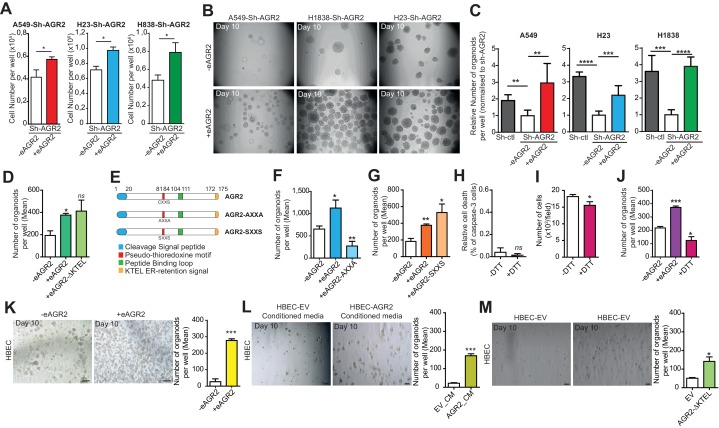
Extracellular AGR2 boosts the organoid-initiating frequency.(A) Quantification of the numbers of cells per wells following the addition of AGR2 in the extracellular medium (+eAGR2). Data are represented as mean ± SEM of at least 3 independent experiments. *p<0.05. (B) Representative brightfield images of tumor organoids grown in 3D from cells harboring Sh-AGR2 in presence (+eAGR2) or not (-eAGR2) of AGR2 in the ECM (n = 3). (C) The bar graphs show the mean of organoids per well (mean ± SEM.), after 10 days in presence (+eAGR2) or not (-eAGR2) of AGR2 in the ECM, (n = 3). The P values are relative to untreated cells. **p≤0.01, ***p≤0.001 and ****p≤0.0001. (D) The bar graphs show the number of organoids per well in absence (-eAGR2) of AGR2 as compared to cells in presence either of AGR2-AXXA mutant (+eAGR2-AXXA) or AGR2 wt (+eAGR2). (E) Schematic representation of AGR2 showing the distribution of AGR2’s principal domains and its mutants AXXA and SXXS. (F) The bar graphs show the number of organoids per well in absence (-eAGR2) of AGR2 as compared to cells in presence either of AGR2-AXXA mutant (+eAGR2-AXXA) or AGR2 wt (+eAGR2). (G) The bar graphs show the number of organoids per well in the absence (-eAGR2) of AGR2 as compared to cells in presence either of AGR2-SXXS mutant (+eAGR2-SXXS) or AGR2 wt (+ eAGR2). (H) Quantitation of cell death in H23-Sh-AGR2 depleted cells (Sh-AGR2) in absence (-DTT) or in the presence (+DTT) of DTT. Results are representative of three independent experiments. The cell death rate was determined by the percentage of caspase-3 positive cells. n.s: not significant. (I) Growth of cells in H23-Sh-AGR2 depleted cells (Sh-AGR2) in absence (-DTT) or in presence of (+DTT) DTT (three independent experiments). Data are mean ± SEM. *p<0.05. (J) The bar graphs show the number of H23-Sh-AGR2 depleted organoids per well in absence (- eAGR2) of AGR2 as compared to cells in presence either AGR2 wt (+eAGR2) or DTT (+DTT). Data are mean ± SEM. *p<0.05 and ***p≤0.001. (K) Representative images of the organoids formed by HBEC in the presence (+eAGR2) or absence (-eAGR2) of AGR2 in the ECM. The bar graph shows the mean of organoids per well (mean ± SEM., n = 3). The p values are relative to untreated cells. ***p≤0.001. (L) Representative images of the organoids formed by HBEC in the presence of conditioned medium from HBEC-vector cells (EV_CM) or in the presence of conditioned medium from HBEC-AGR2 cells (AGR2_CM) in the ECM. The bar graph shows the mean of organoids per well (mean ± SEM., n = 3). The p values are relative to untreated cells. ***p≤0.001. (M) Representative images of the organoids formed by HBEC overexpressing AGR2-AXXA (HBEC-AGR2-AXXA) or not (HBEC-EV). The bar graph shows the mean of organoids per well (mean ± SEM., n = 3). *p<0.05.